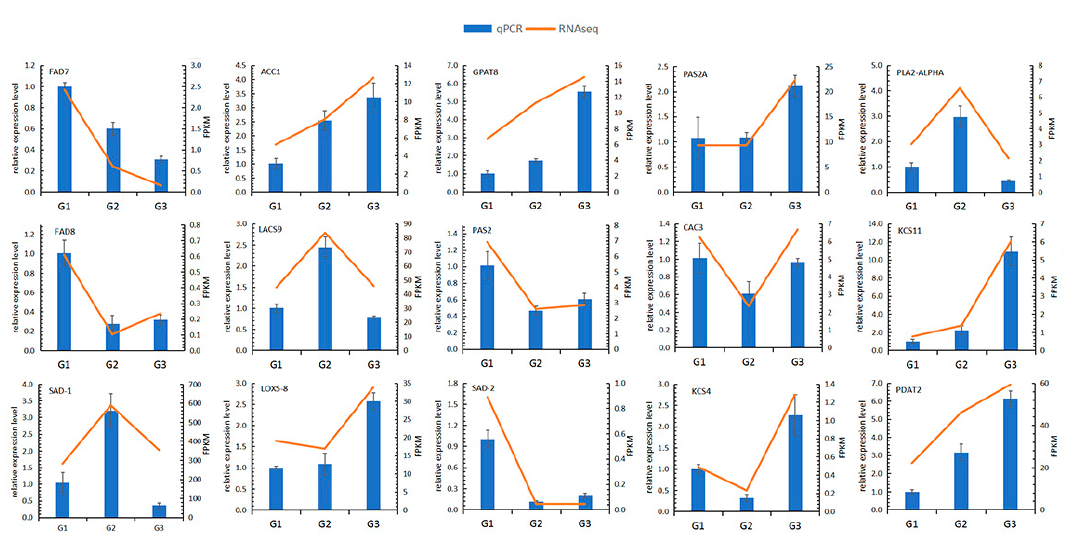
Figure 3. QRT-PCR verifies the quality of transcriptome sequencing. The blue bar graph represents the relative expression level of the sample (left y -axis), and the yellow line graph represents the normalized result (FPKM) of the sample in the transcriptome (right y -axis).